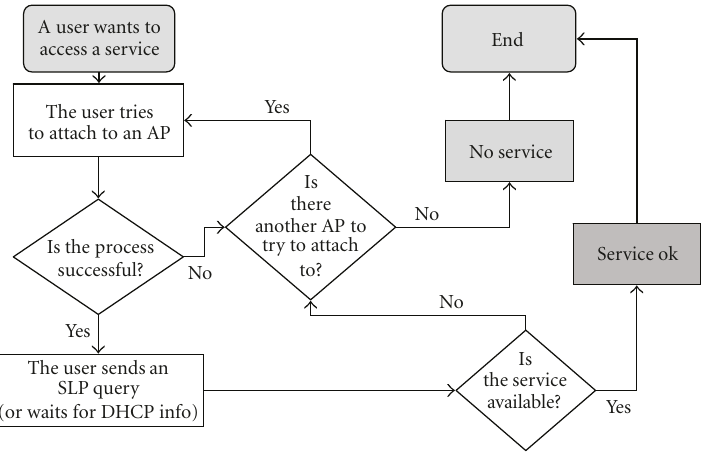
Figure 6: Service discovery: the legacy